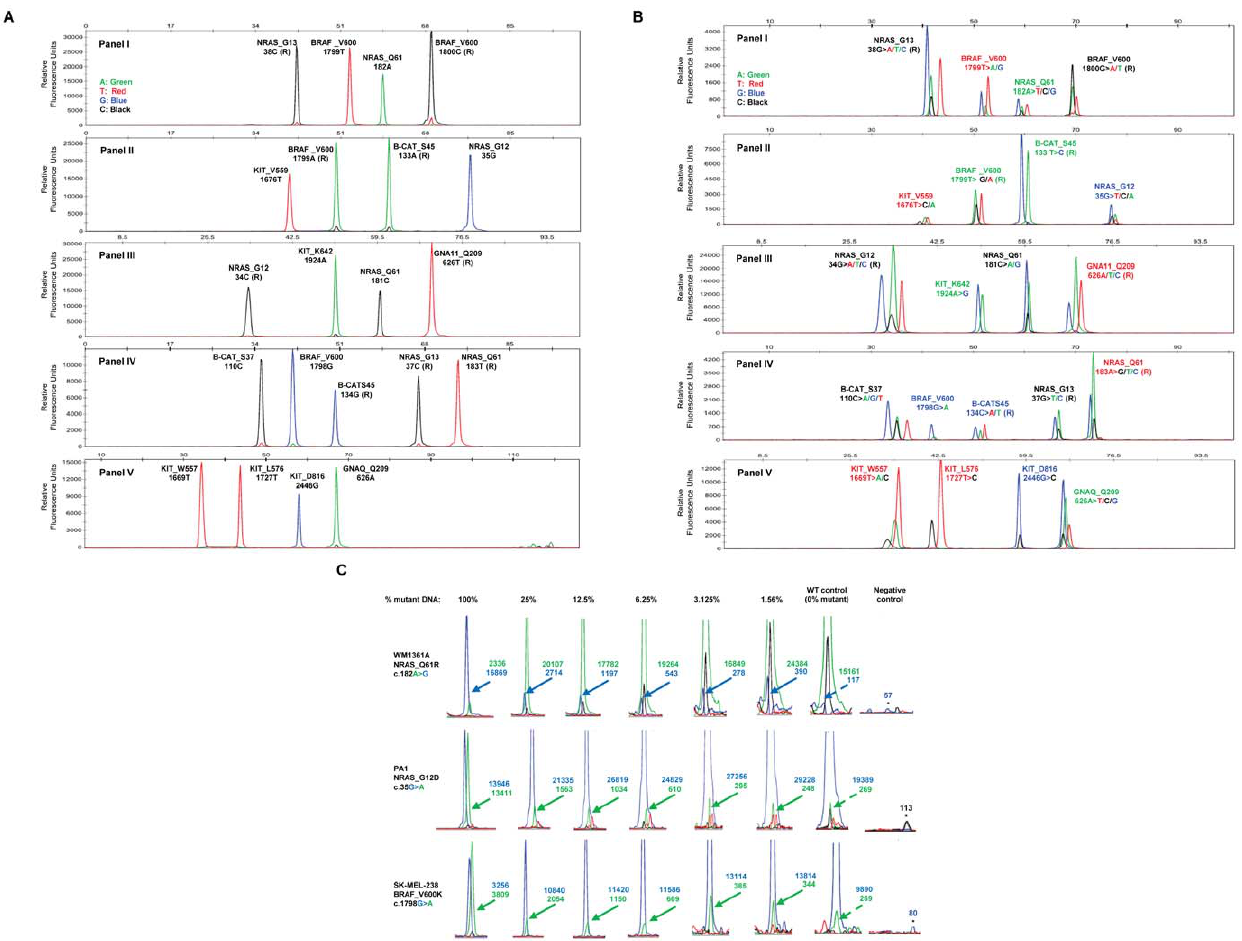
Figure 1. Melanoma SNaPshot screen (v1.0). A, five multiplexed panels can detect the mutational status of twenty gene loci. Each peak color represents a particular nucleotide at that locus. The gene name, amino acid, and nucleotide are labeled above each peak. An ‘‘(R)’’ after the nucleotide denotes a reverse extension primer. B, pan-positive control for melanoma SNaPshot screen. Peaks are labeled as described in A. C, SNaPshot sensitivity measurement using cell line DNA carrying known mutations. Numbers indicate the arbitrary fluorescence units of WT (panel 1: green, panels 2, 3: blue) and mutant (panel 1: blue, panels 2, 3: green) peaks. Solid arrows indicate mutant peaks and dotted arrows show background peaks. Background peaks in the negative controls (far right panel) are indicated by their peak height and a star Figure 2 ; Table S10 ), including 57, 23, 6, 3, and 2 mutations in